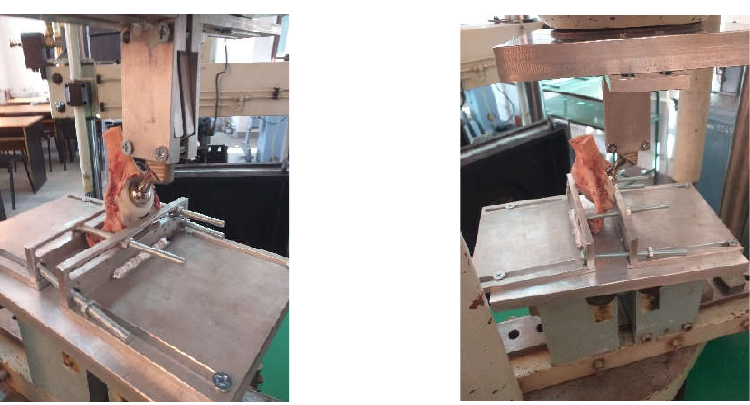
Figure 18. The prosthesis with titanium augment fixed on the EDZ20 machine.